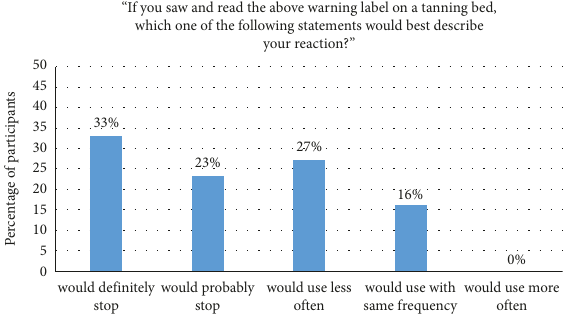
Figure 3: Tanning bed users’ reaction to warning